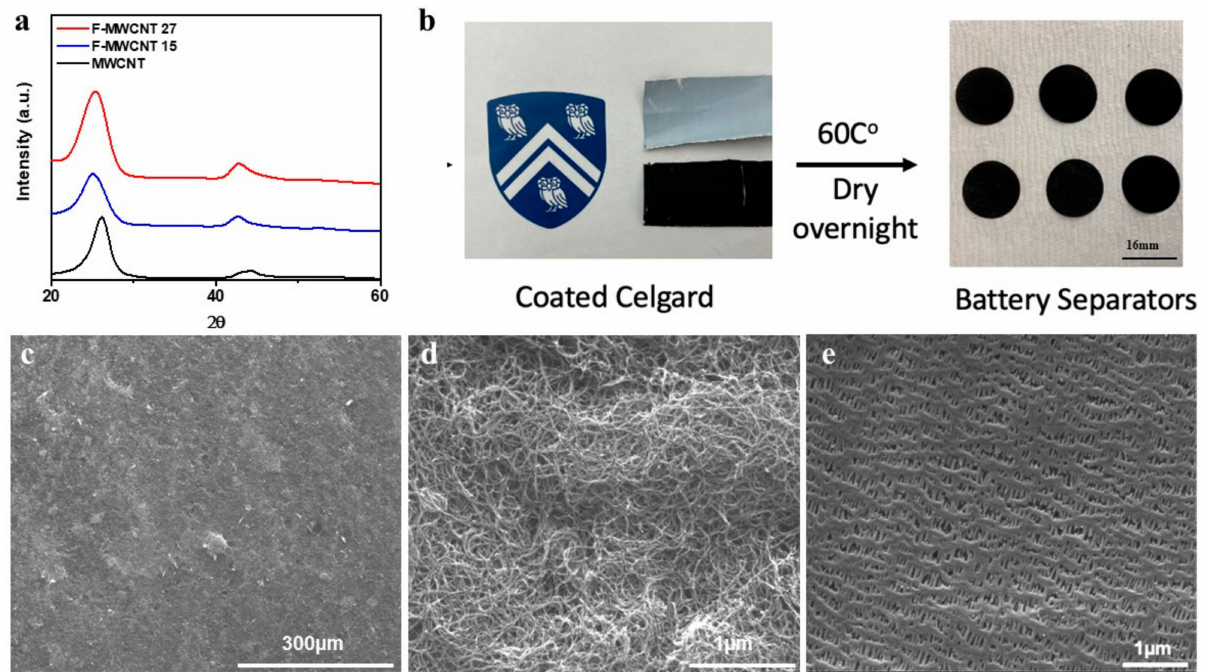
Figure 2. ( a ) X-ray diffraction spectra of pristine MWCNTs (black), FMWCNT-15 (blue) and FMWCNT-27 (red). ( b ) Pictorial representation of the front and back side of a coated separator. After drying, the bifunctional separators were cut into 16 mm diameter disks. SEM images of the coated ( c , d ) and opposite side ( e ) of the FMWCNT-27 bifunctional